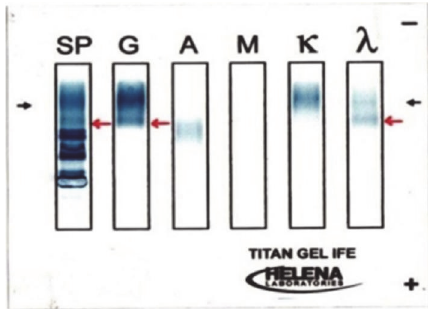
Figure 4: Results of immunofixation electrophoresis of the serum. Abnormalities of the 𝜆 -light chain are present (red arrows). SP is the total proteins. G is the IgG, A is the IgA, and M is the IgM.